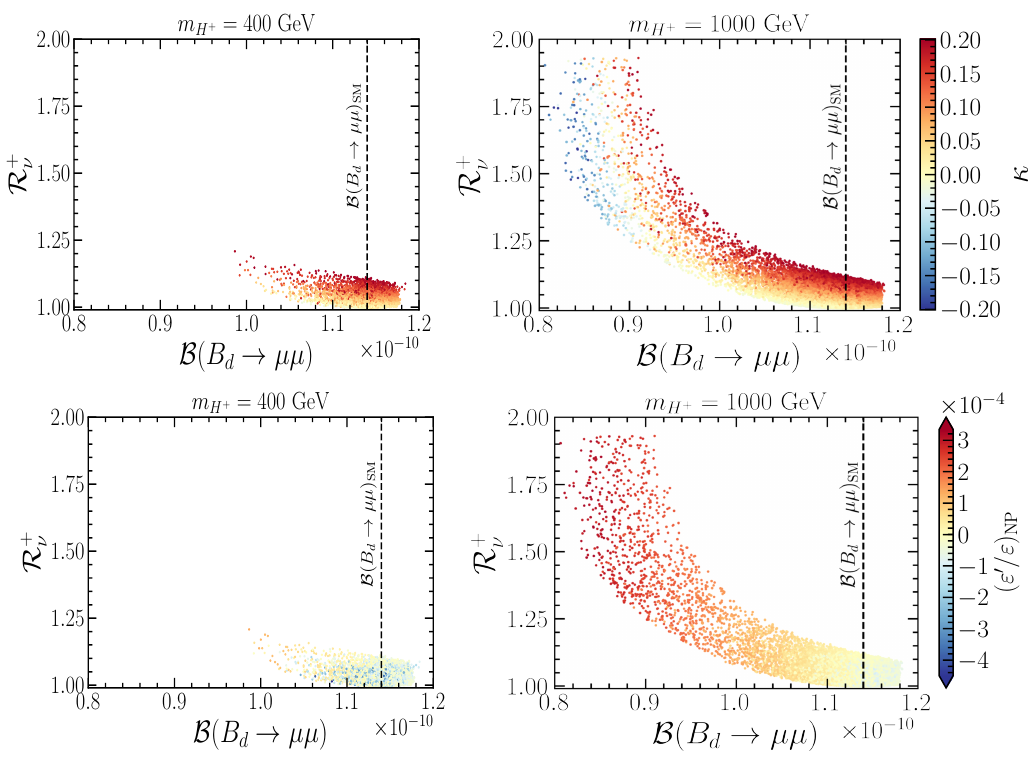
Figure 10 . Correlations between K + → π + ν ¯ ν , B d → µ + µ − , and κ (upper) and ( ε 0 /ε ) NP (lower).